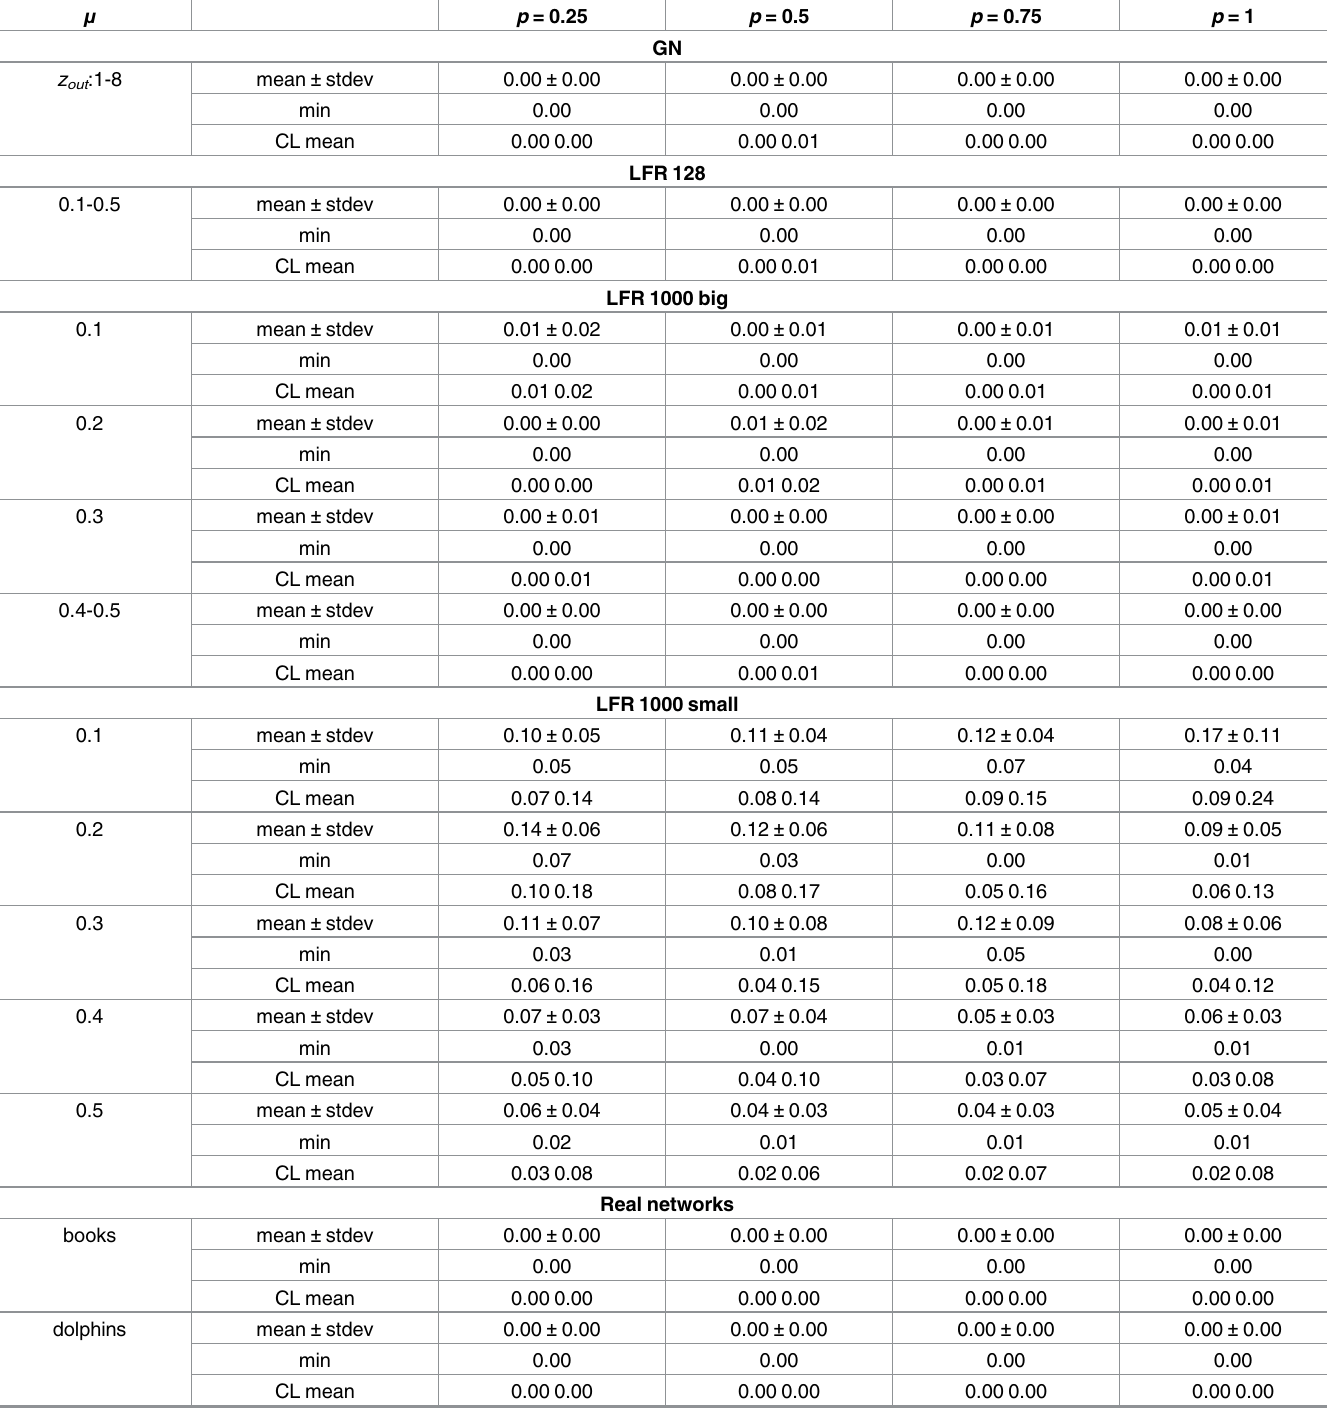
Table 1. Fraction of nodes that can improve their payoffs by unilateral deviation in solutions reported by p MNEO for networks with known